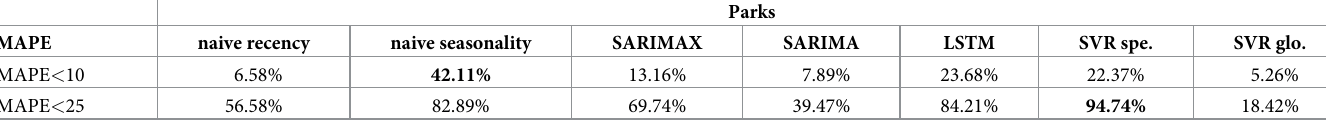
Table 4. Baseline results for 27 museums in U.K. (indoors). The values in the table represent the percentage of attractions with MAPE in each specified range. Museums MAPE naive recency naive seasonality SARIMAX SARIMA LSTM SVR spe. SVR glo. MAPE < 10 25.93% 18.51% 14.81% MAPE < 25 70.37% 81.48%